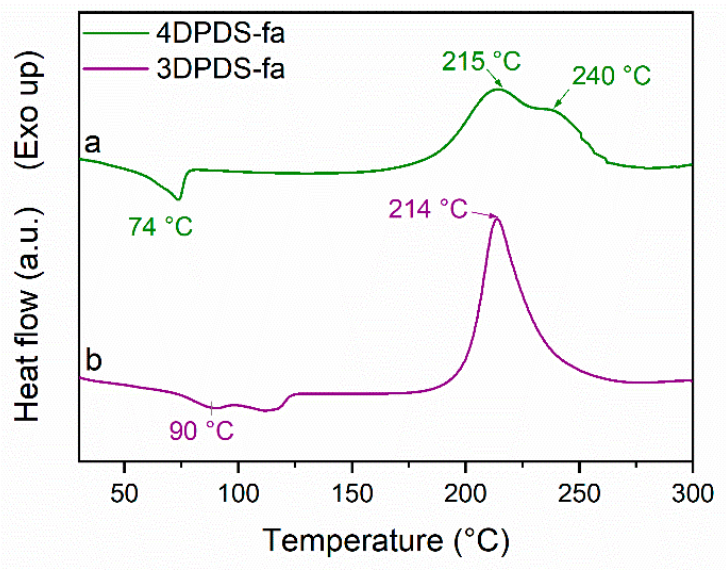
Figure 2. Differential scanning calorimetry (DSC) thermograms of dibenzoxazines containing disulfide: ( a ) 4DPDS-fa, and ( b ) 3DPDS-fa.